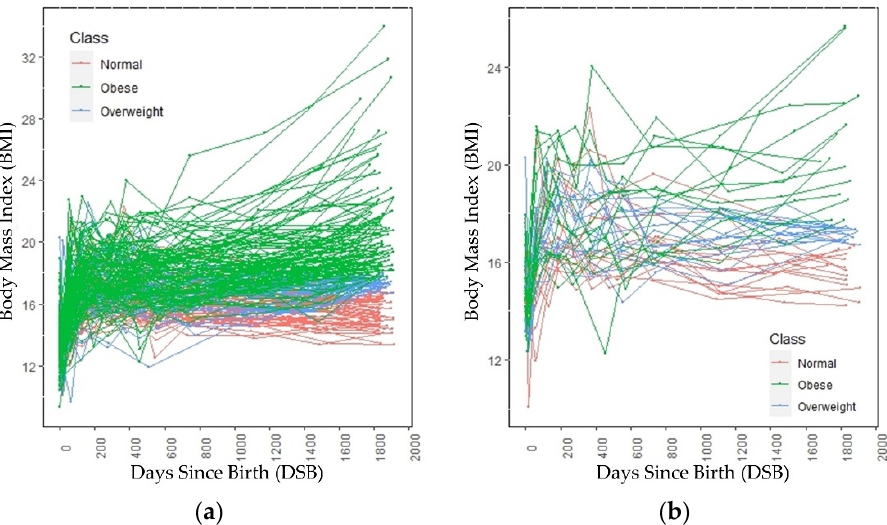
Figure 2. BMI trends through age 5 across ( a ) all subjects and ( b ) a randomly selected subset of subjects.